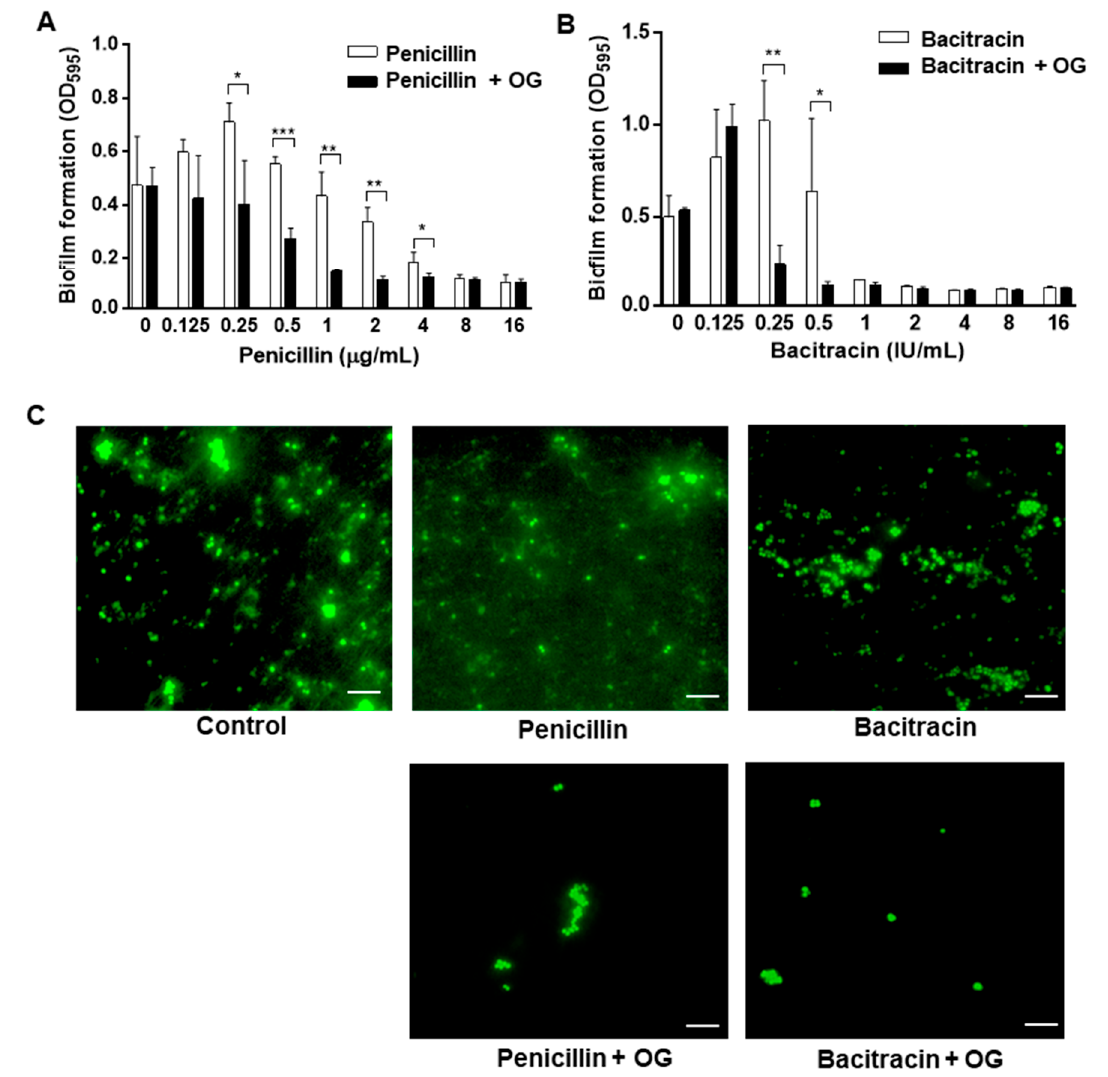
Figure 3. Synergistic inhibition of Staphylococcus epidermidis biofilms by penicillin ( A ) and bacitracin ( B ) in combination with 4 µg/mL octyl gallate (OG). The presented data are the means and standard deviations of three samples in a single experiment. The experiment was repeated three times and produced similar results. Statistical significance was determined with Student’s t -test by comparing samples treated with an antibiotic alone and those treated with an antibiotic and OG. *: p < 0.05, **: p < 0.01, ***: p < 0.001. ( C ) Fluorescence microscopy observation of S. epidermidis biofilms stained with SYTO 9. The scale bar indicates 5 µm.